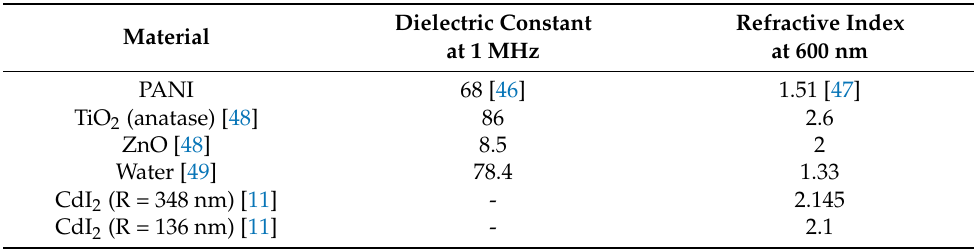
Table 1. Dielectric constants and refractive indexes of the mediums at room temperature (298.15 K) considered in this study.